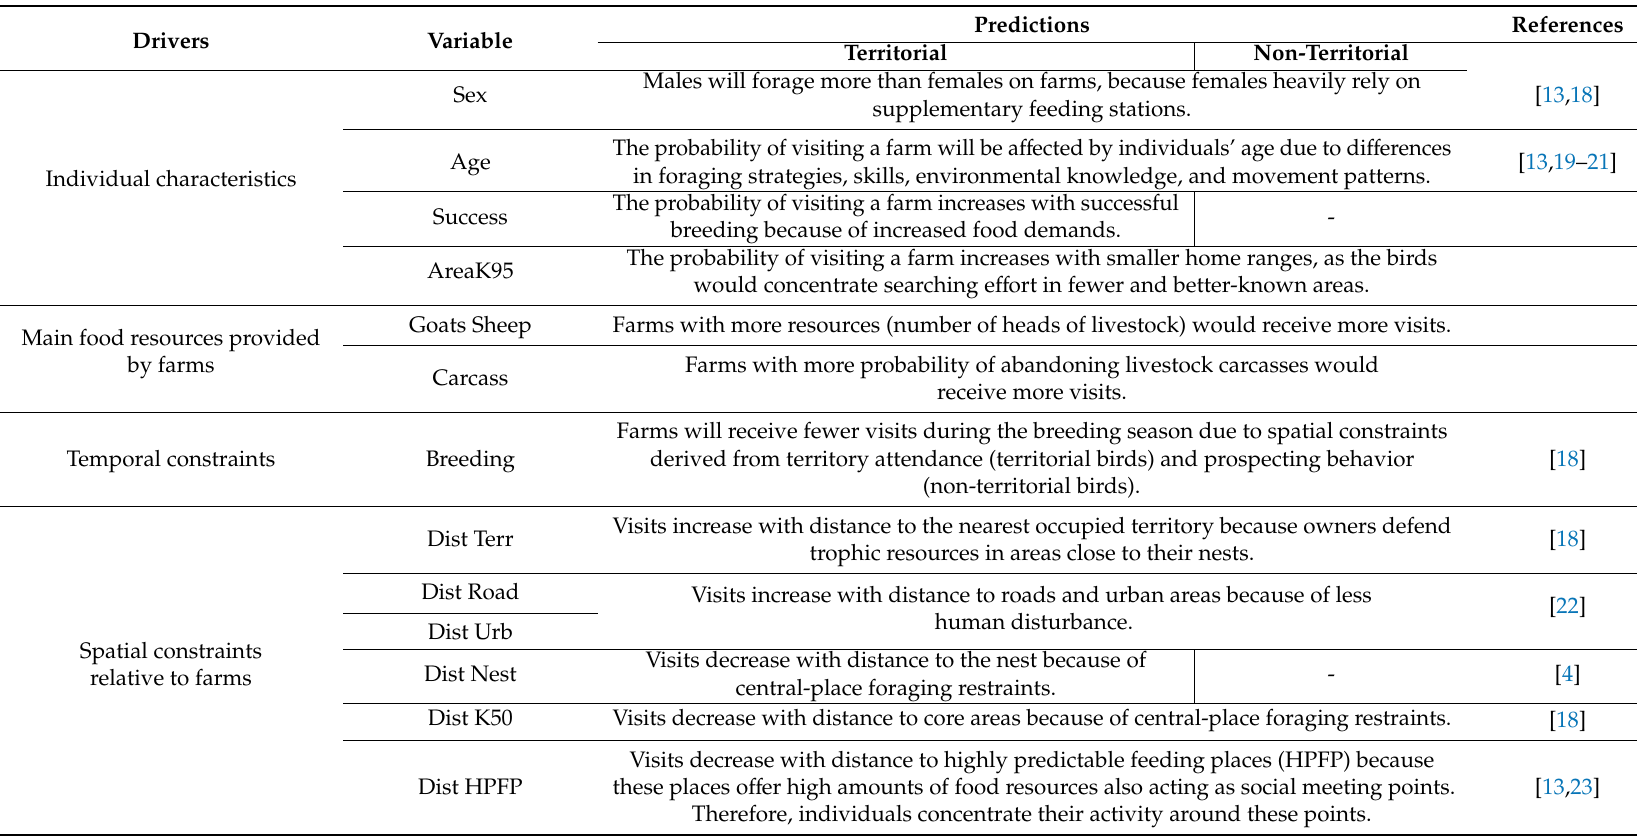
Table 1. Predictions for each explanatory variable included in the analyses aimed at determining drivers of the selection of farms by Canarian Egyptian Vultures in Fuerteventura (Canary Islands). See Table 2 for a full description of considered